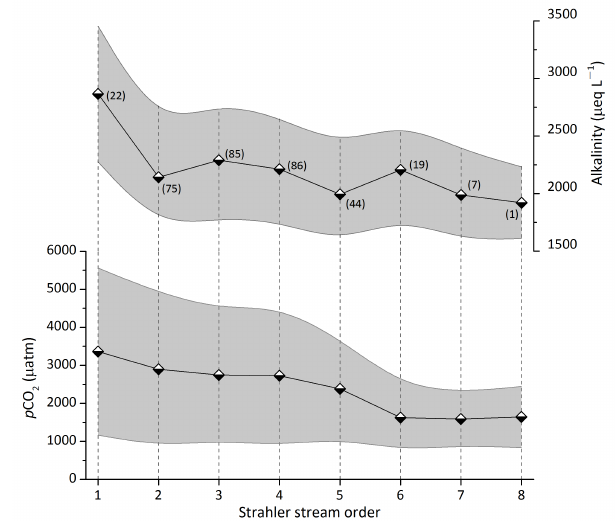
Figure 8. Decreasing alkalinity (top) and p CO 2 (bottom) with in- creasing Strahler stream order. The grey shade denotes standard de- viation and the numbers in parentheses represent the number of sta- tions aggregated for each stream